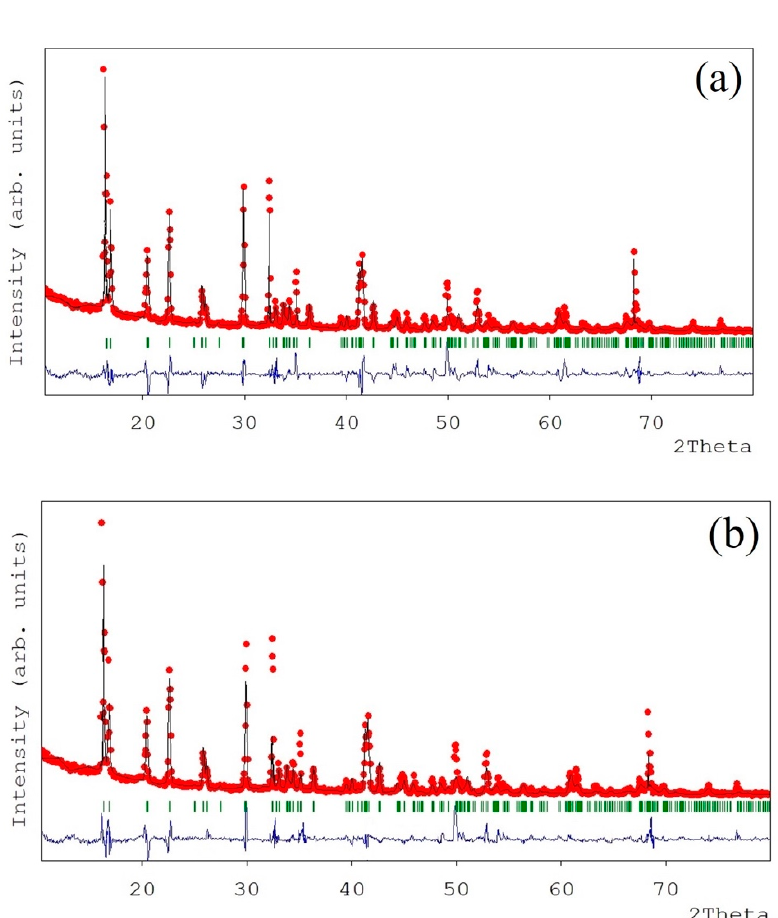
Figure 4. Observed, calculated, and difference XRD patterns obtained in the Rietveld refinements for ( a ) FFC and ( b ) AFC samples.